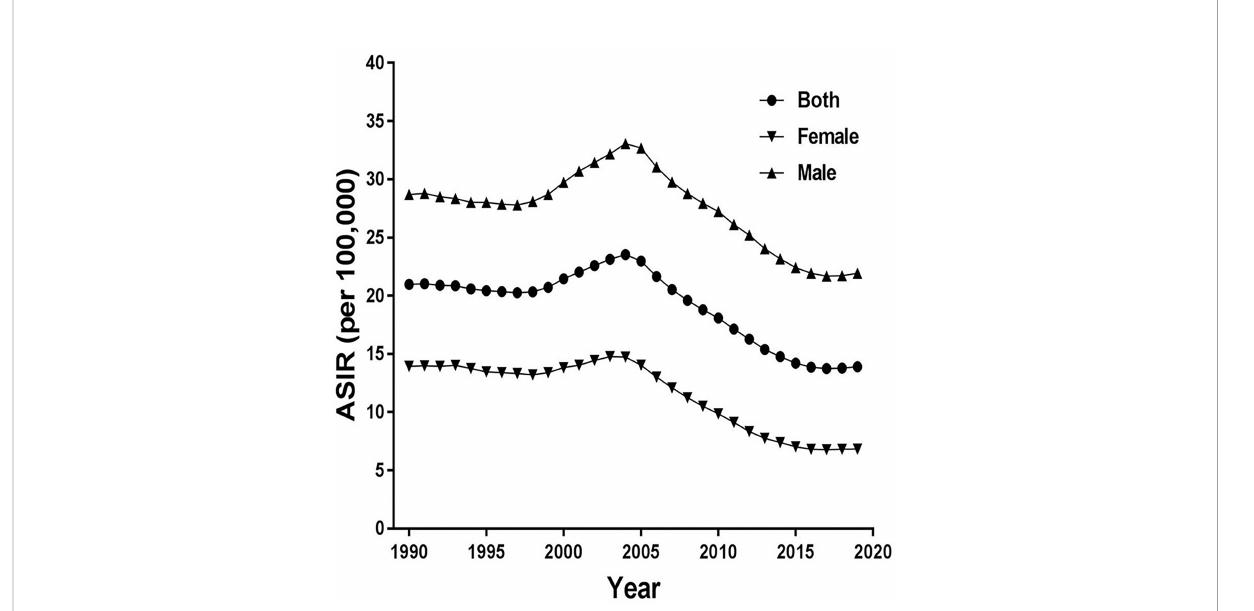
FIGURE 1 Trends of the age-standardized incidence rates (ASIR) for esophageal cancer from 1990 to 2019 in